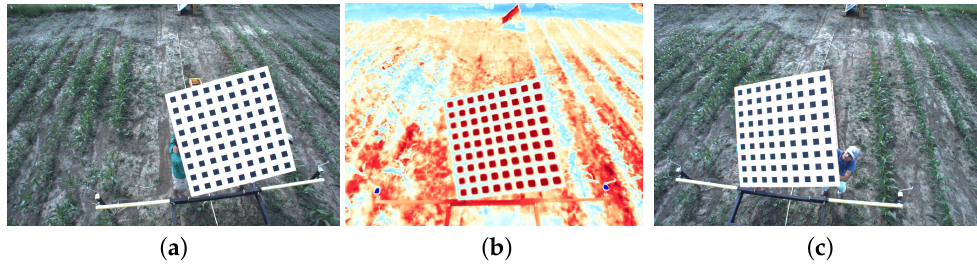
Figure 12. Three typical images of the aluminum + paper pattern used for calibration of RGB and IR cameras. ( a ) Left RGB; ( b ) IR Camera; ( c ) Right RGB.